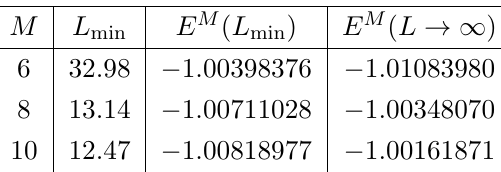
Figure 4 . Plot of E M ( L ) with M = 10, for the energy in Schnabl gauge as a function of the level. The dashed line represents the analytical value (cid:0) 1.